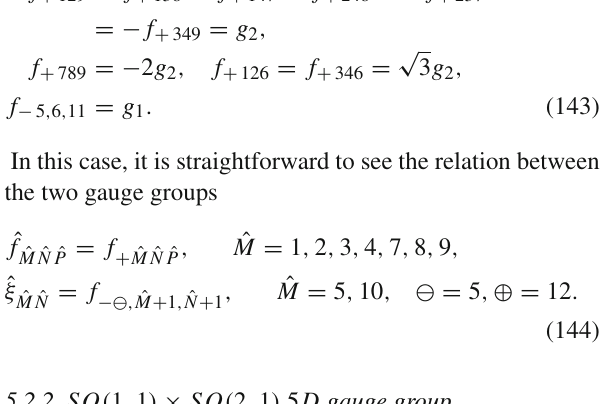
Table 2 The identification between five- and four-dimensional gaugings. Gauge groups with #1 , 2 , 3 in